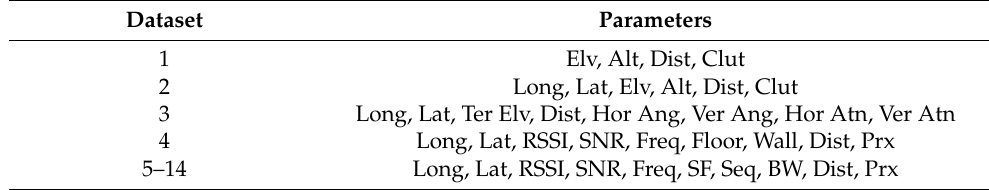
Table 5. Parameters of each dataset.